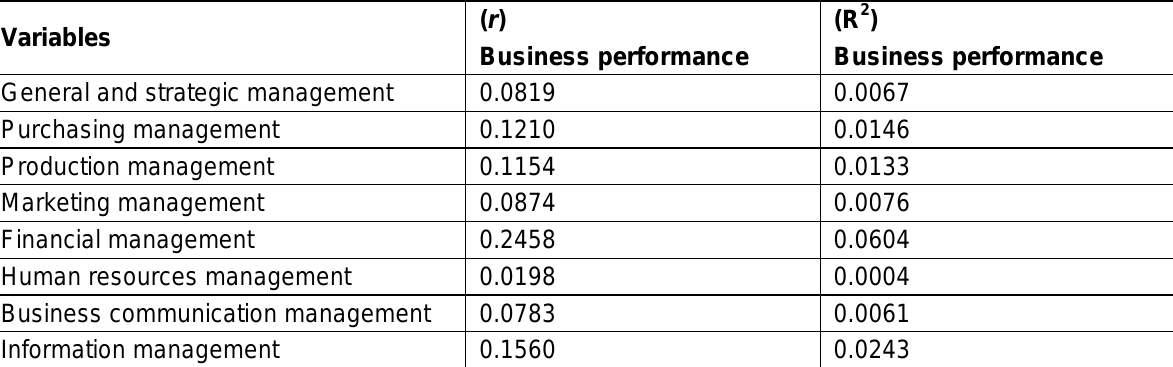
Table 4: Pearson correlation coefficients and the linear regression analysis